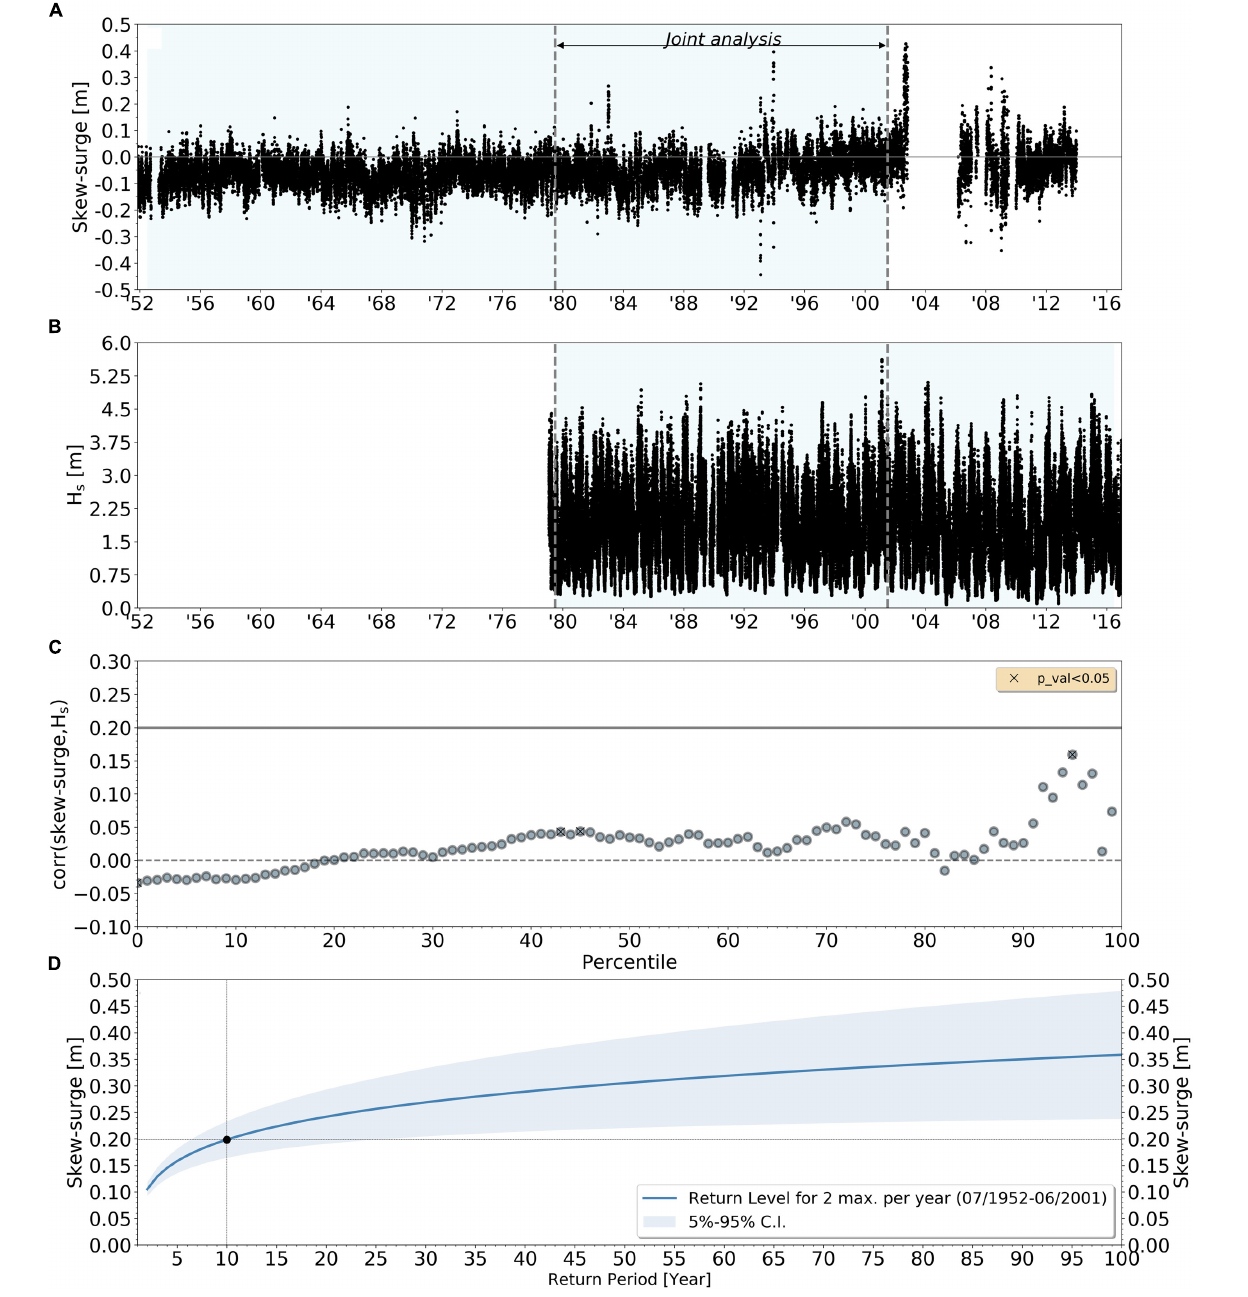
FIGURE 4 | Timeseries of skew-surge derived from the Cartagena tide-gauges (A) ; timeseries of significant wave height ( H s) from the WWIII reanalysis at the closest grid point with respect to Cartagena (B) ; Kendal correlation between skew-surge and H s (C) for the period indicated as joint analysis in the top panel (the black cross remarks significant correlation at 95%, see legend). The blue shading depicts the timeseries used to estimate the extreme events in the independent assessment; return level for skew-surge using 2 max. per year (D) . The blue shading reflects the 5–95% range of